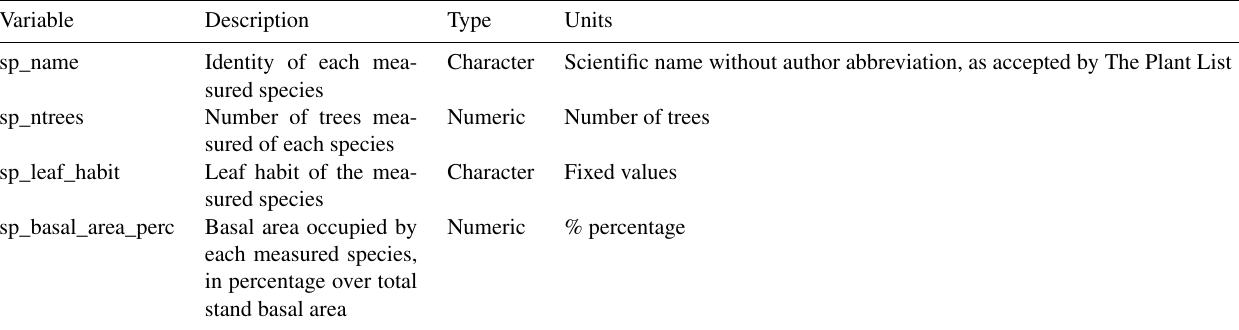
Table A4. Description of species metadata variables in SAPFLUXNET